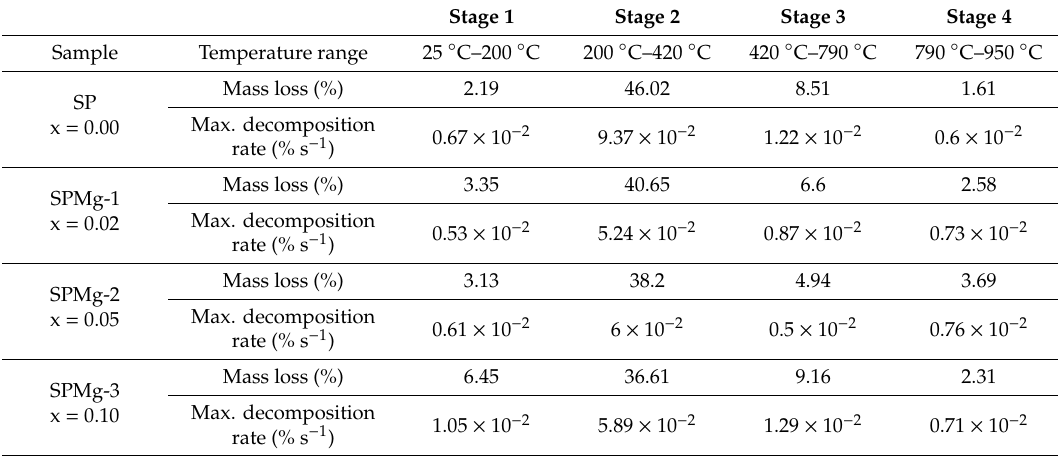
Table 1. Percentages and maximum rates of mass loss of the thermal decomposition zones of the synthesis